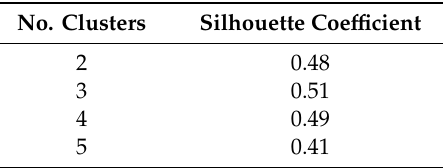
Table 9. Silhouette Coefficient obtained for different number of clusters applied to one single HVAC